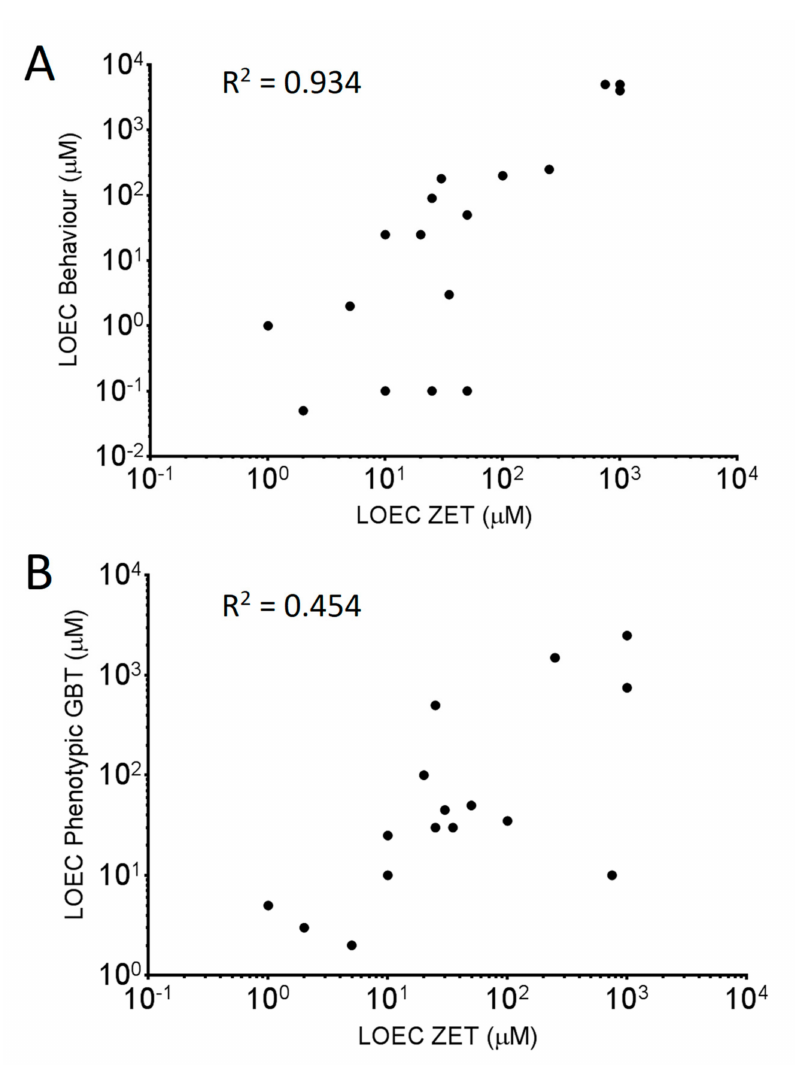
Figure 2. Correlation analysis comparing the LOEC rankings between the ZET assay and the Behavioral endpoint of the GBT assay ( A ) and between the ZET assay and the phenotypic endpoint from the GBT assay ( B ). R 2 values for each are embedded in the